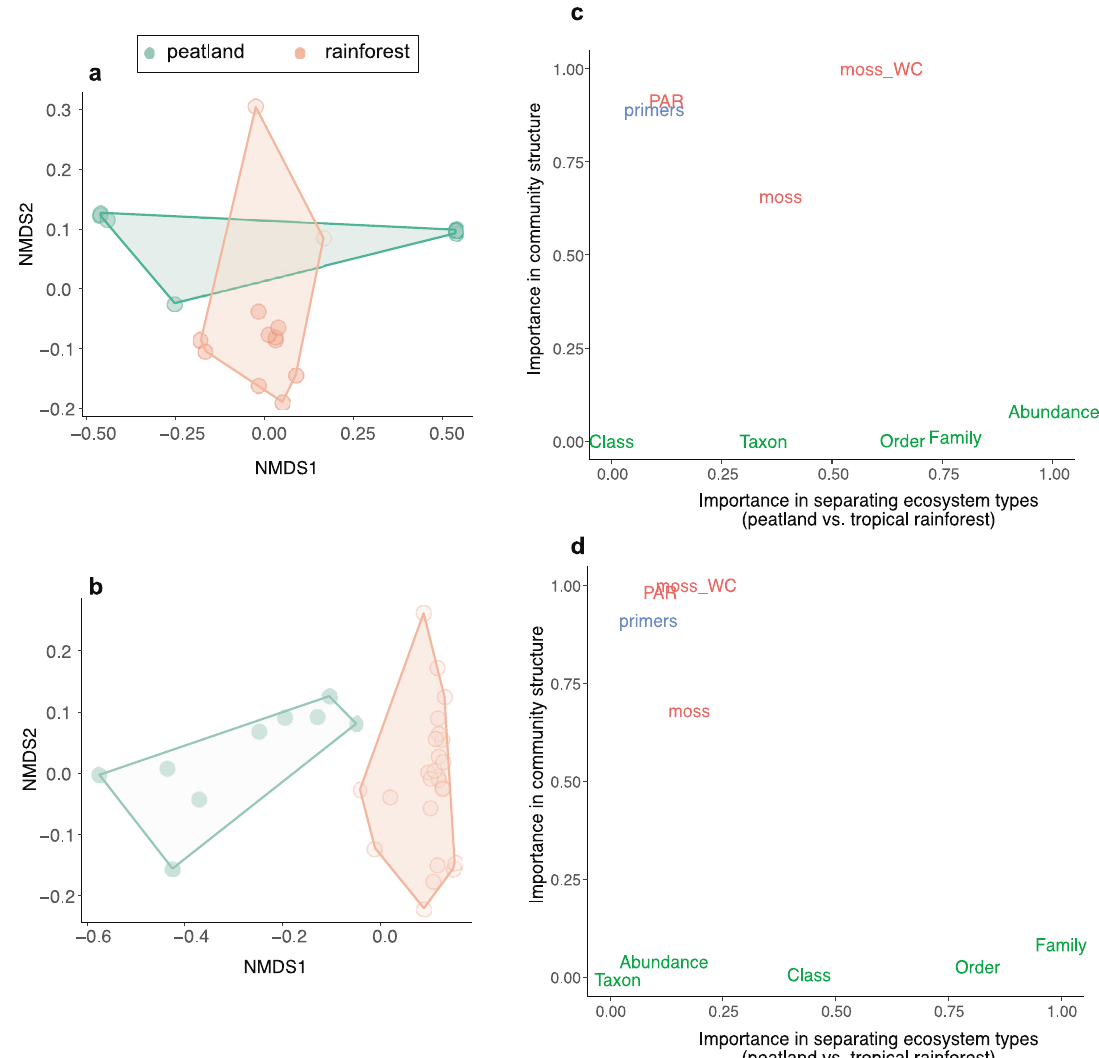
conditions (bryophyte water content and light availability) directly determined photosynthetic microbial community composition (r ∂ = − 0.71) and its photosynthetic ef fi ciency ( Φ PSII; r ∂ = − 0.45). Second, the model revealed that the occurrence of photosynthetic protists was a pivotal factor in determining the contribution of photosynthetic microbes to the bryophyte C uptake. Speci fi cally, the occurrence of photosynthetic protists strongly determined the ratio cyanobacteria:total photosynthetic microbial abundance in the community (r ∂ = 0.77), which in turn determined the microbial photosynthetic ef fi ciency ( Φ PSII, r ∂ = 0.65) and microbial CO 2 fi xation rates (r ∂ = − 0.79). In other words, photosynthetic microbial communities with more cyanobacteria than photosynthetic protists fi xed less C and therefore contributed less to the total C uptake of the bryophyte. Finally, our results highlighted that total bryosphere C fi xation directly depended on photosynthetic community composition (r ∂ = − 0.58).